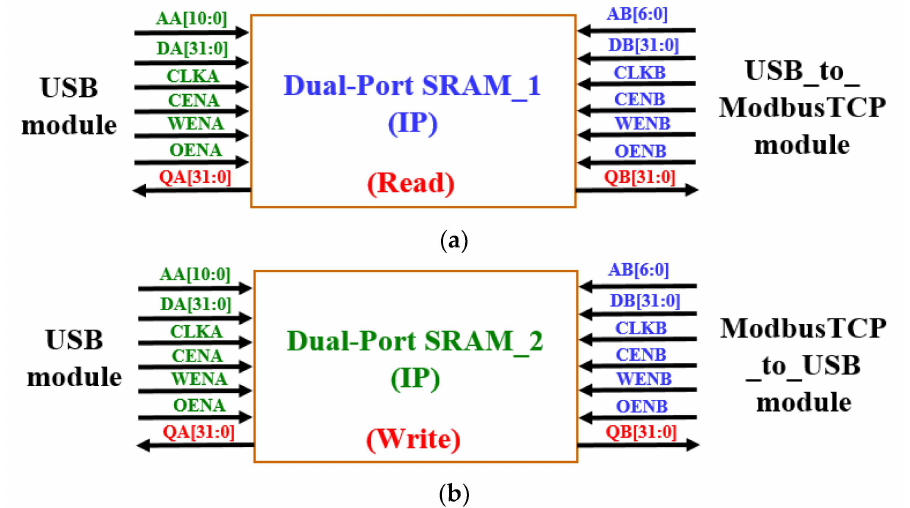
Figure 3. Architecture diagrams of ( a ) Dual-Port SRAM_1 and ( b ) Dual-Port